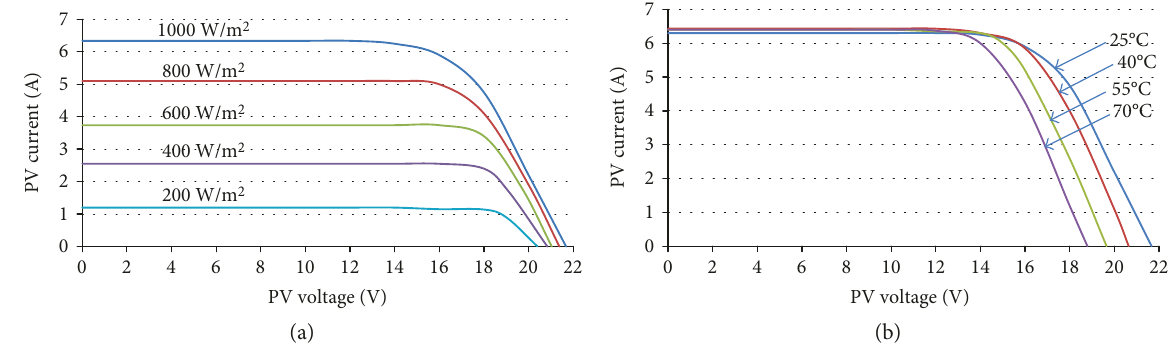
Figure 4: (a) Experimental I - V characteristics with radiation at constant temp. (25 ° C). (b) I - V characteristics with temp. at constant radiation (1000W/m 2